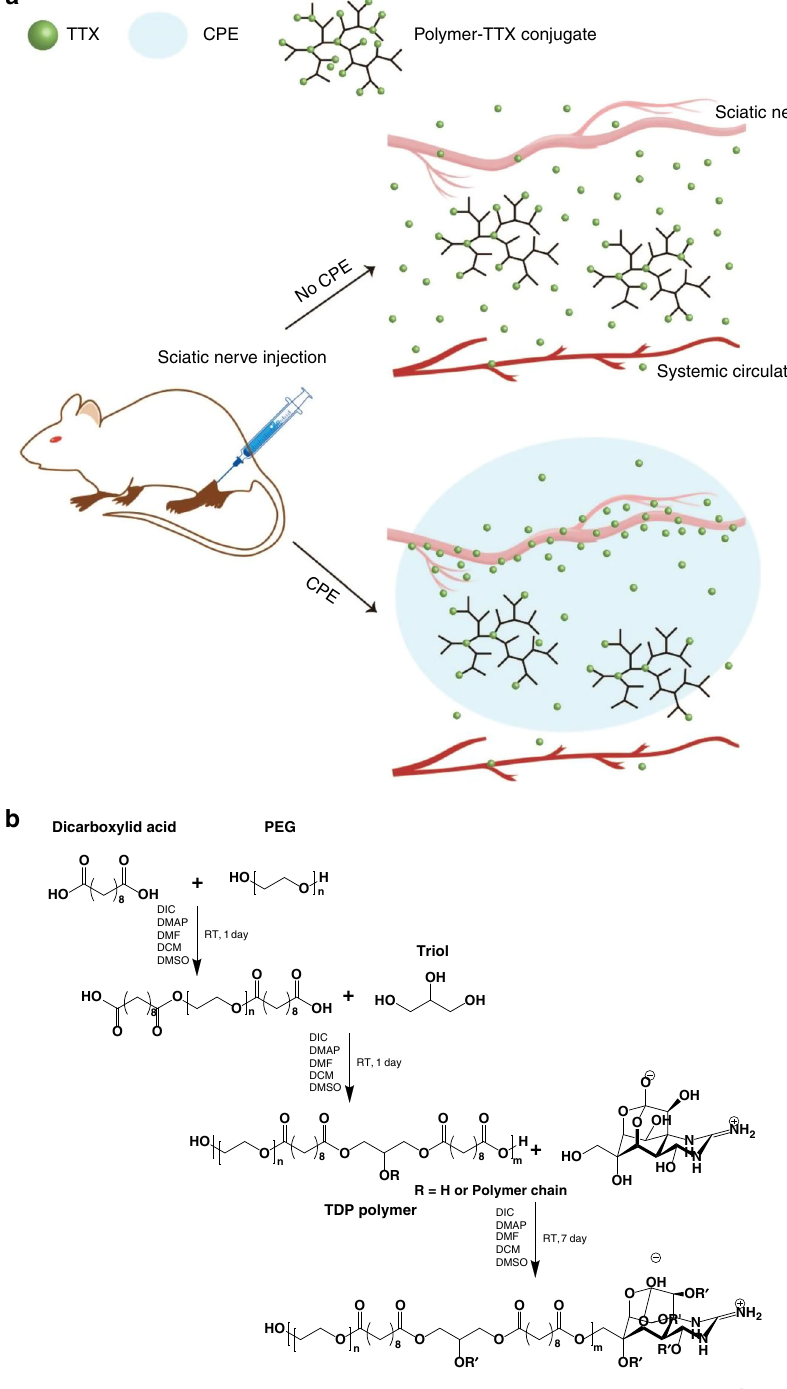
Fig. 1 Design of a sustained release system for prolonged duration local anesthesia. a A polymer – TTX conjugate, designed to have a large TTX content with slow release, is placed near a nerve. Flux of TTX into the nerve is enhanced by a delivery system that acts as a chemical permeation enhancer. The polymer – TTX conjugate, schematized here as a hyperbranched structure has a much higher TTX loading than those actually produced here (which have 0.008 or 0.03 TTX molecules on each polymer chain). b Steglich esteri fi cation to synthesize TDP and TDP – TTX. The fi rst step is optional, depending